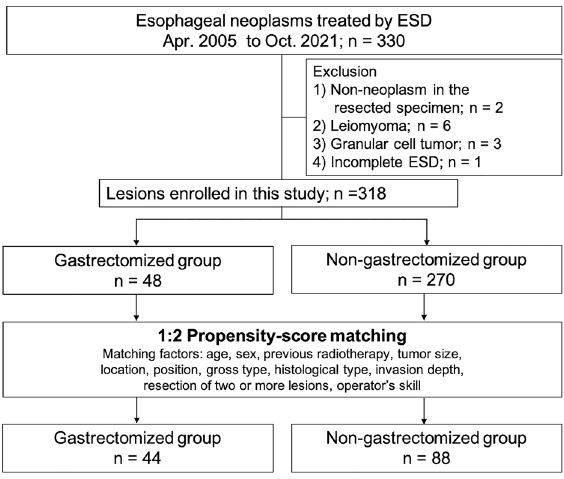
Figure 1. Study flowchart. ESD, endoscopic submucosal